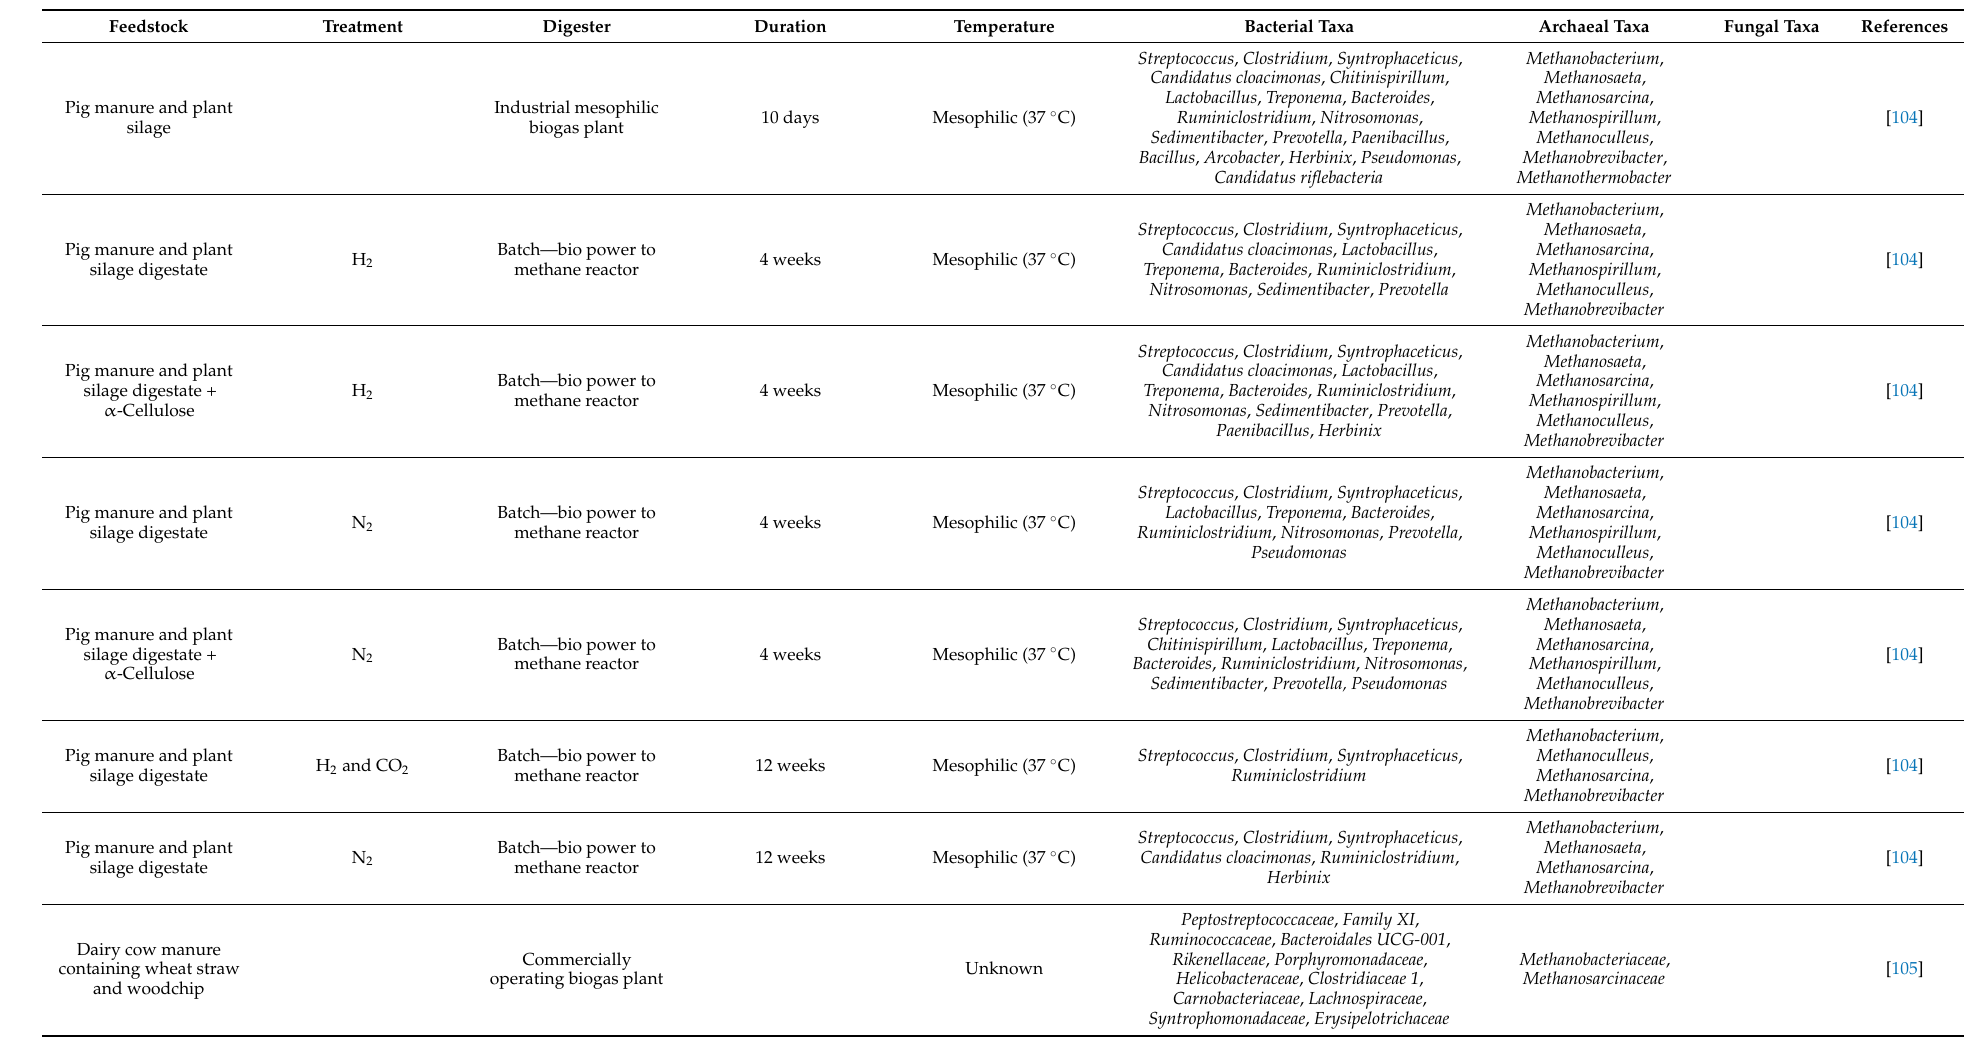
Table 1. Notable microbial communities in digestate arising from various anaerobic